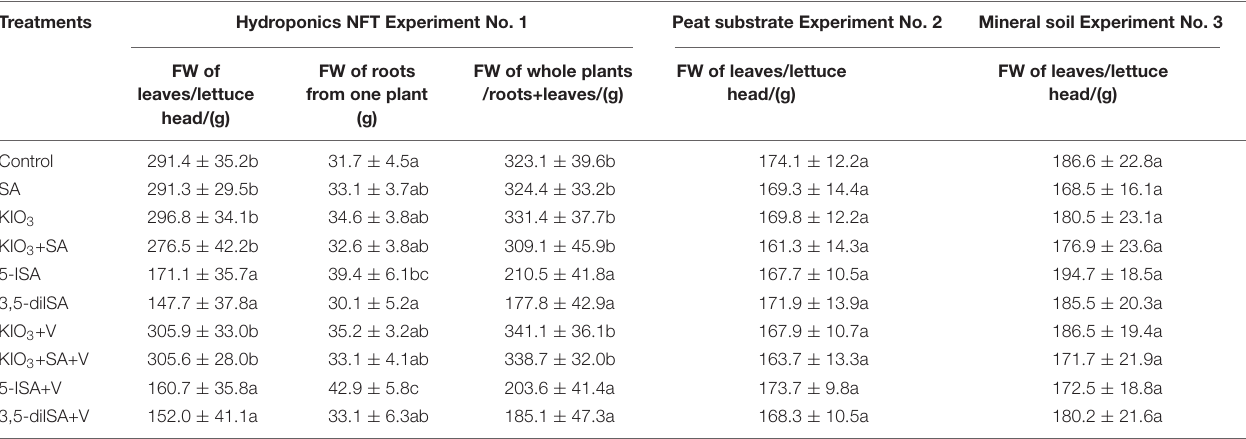
TABLE 3 | Fresh weight of roots, leaves /lettuce head/ and whole plants /roots+leaves/ in hydroponic NFT Experiment No. 1 as well as in lettuce leaves /head/ in pot Experiment Nos. 2 and 3. Treatments Hydroponics NFT Experiment No.